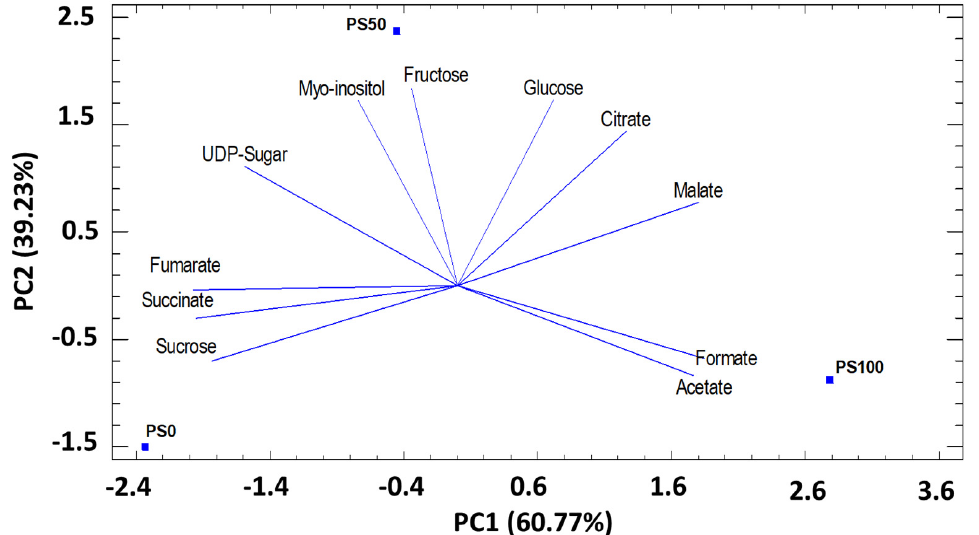
Figure 2. Principal components analysis (PC1 and PC2) for sugar and organic acids identified in pomegranate leaves cultivated in three different substrates. PC1 (60.77%) and PC2 (39.23%). Secondary Metabolites and Others